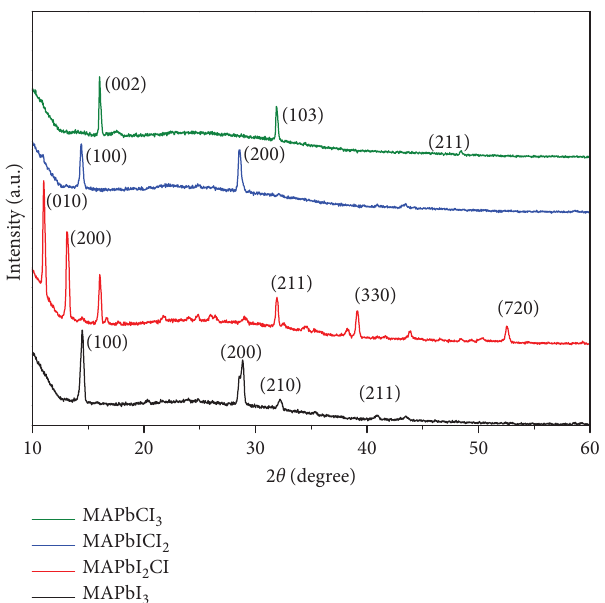
Figure 3: XRD of diferent synthesized perovskite materials.